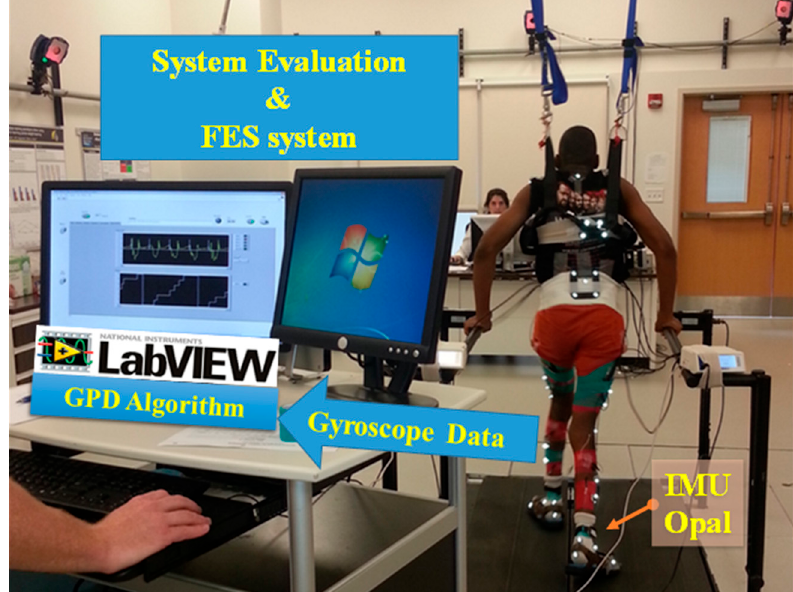
Figure 1. The gait phase detection (GPD) and functional electrical stimulation (FES) system. Shank attached gyroscopes sent data to a rule-based algorithm written in LabVIEW (version 2014, National Instruments, Austin, TX, USA) and all seven phases of gait were detected. A motion capture system was used to evaluate the system.